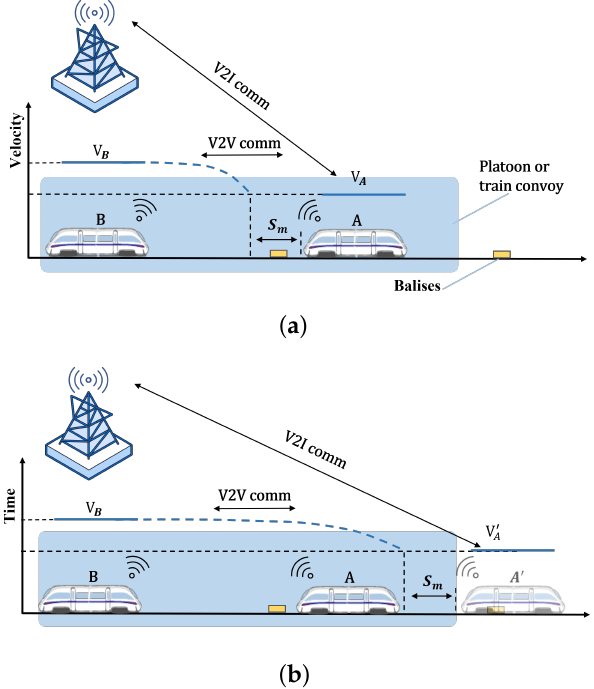
Figure 1. virtual coupling train-following model. ( a ) Schematic system architecture for virtual coupling. ( b ) virtual coupling with the prediction of position and speed of the leading train